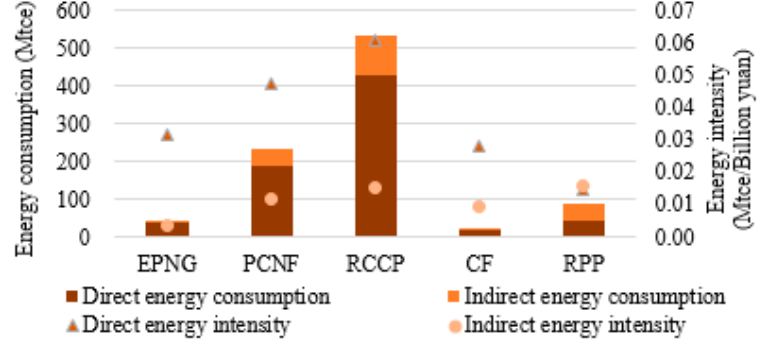
Figure 2. Direct and indirect energy consumption and intensity of the petrochemical industry (2012).